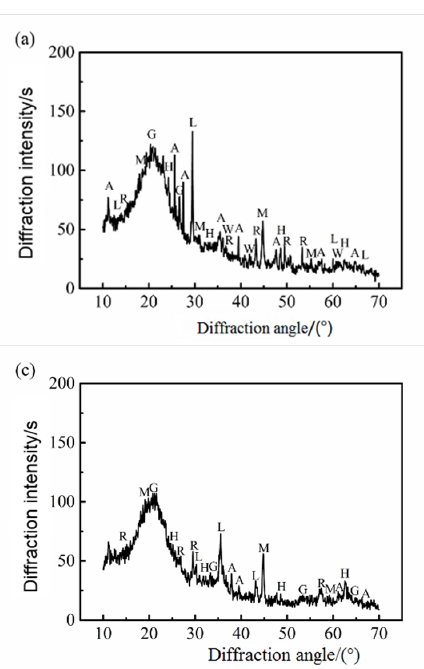
Figure 6. XRD patterns of rust sample of steel bar in ordinary concrete; ( a ) Inner rust layer of B1, ( b ) Outer rust layer of B1, ( c ) Inner rust layer of B2, ( d ) Outer rust layer of B2.